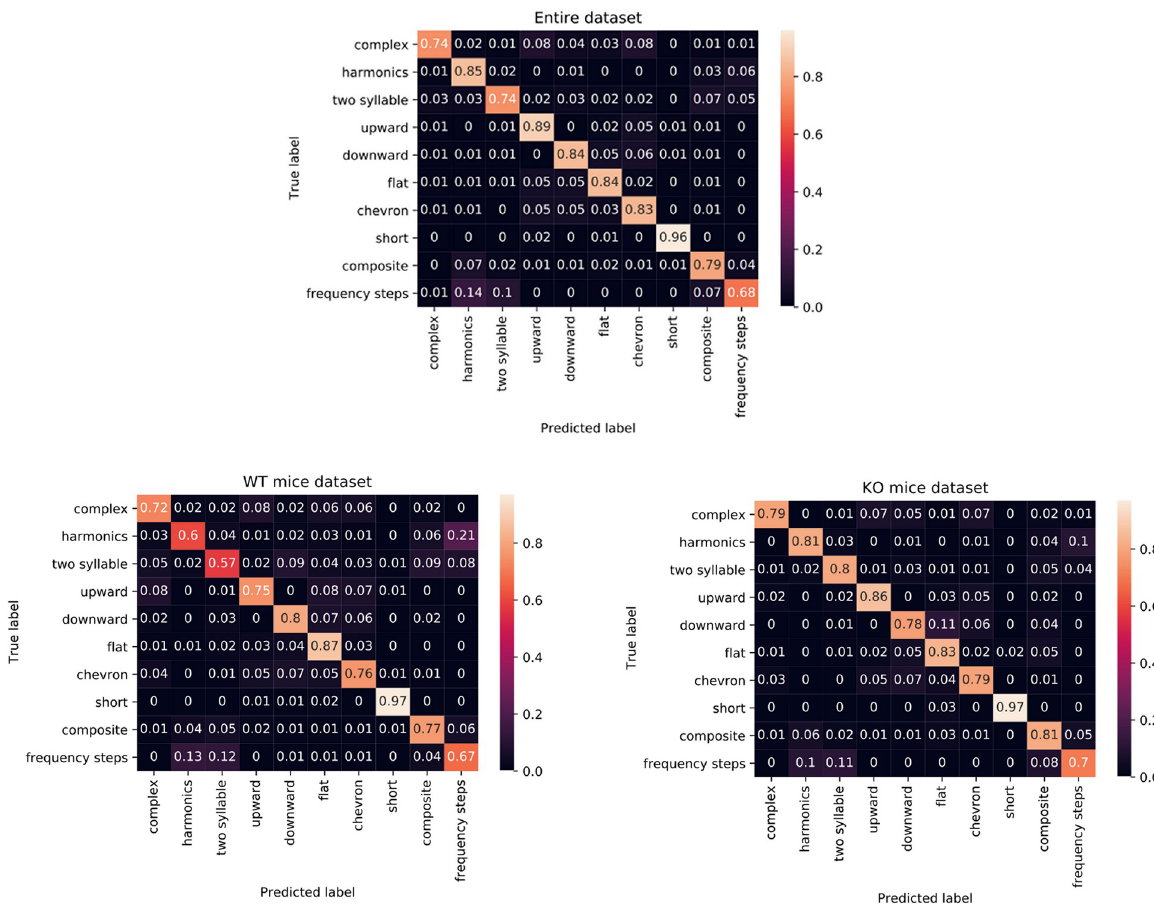
Fig 4. Confusion matrices related to the classification results obtained testing the proposed CNN for the three datasets. On both axes there are the vocalization classes; in particular, the x axis refers to the predicted labels, while the y axis refers to the true ones. Notice that each row value is normalized with respect to the number of vocalizations of that row’s class. The values in the range (0;1) can be interpreted as percentage